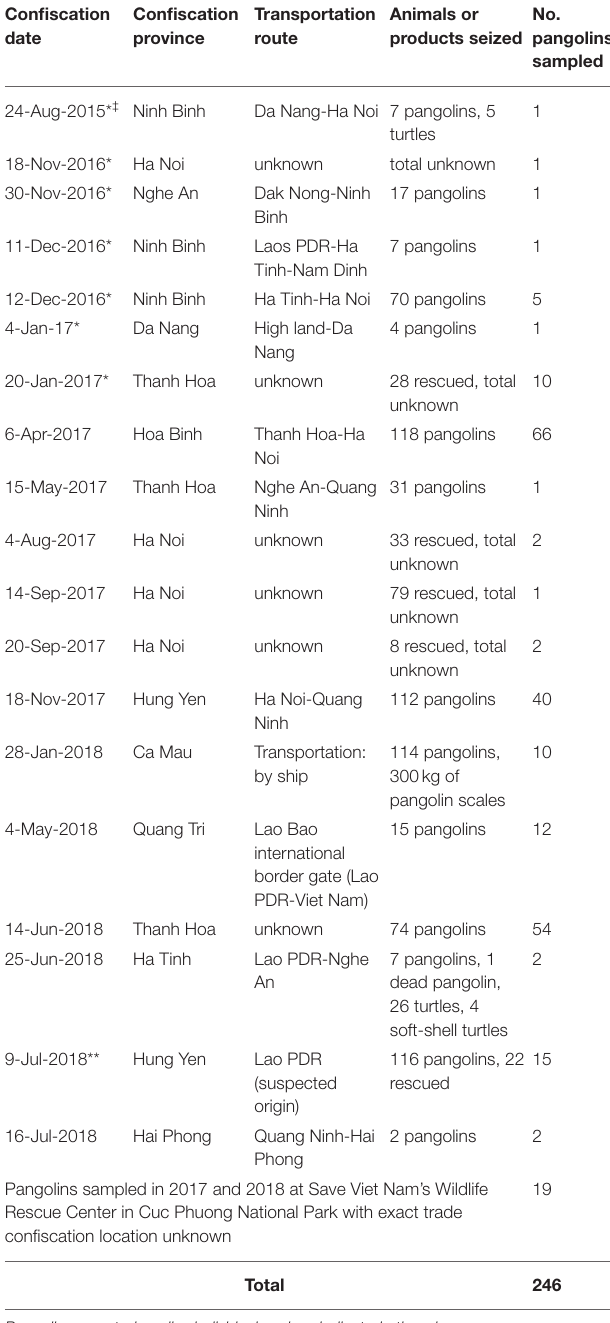
TABLE 1 | Information from wildlife confiscation events associated with the pangolins sampled for testing in this